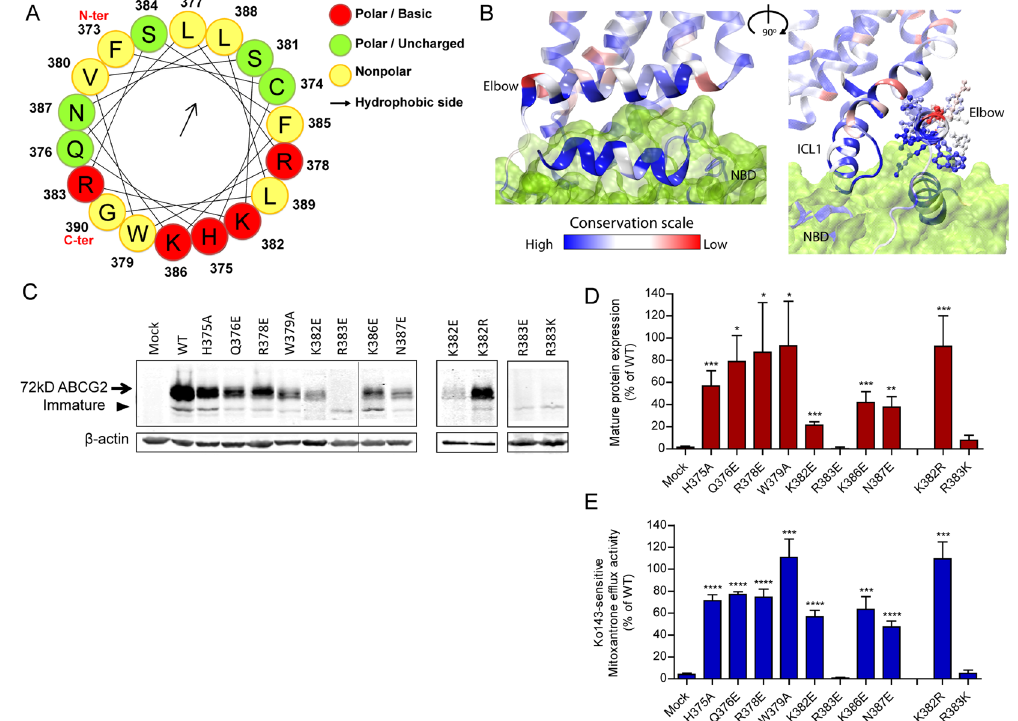
Figure 3. Functional analysis of the elbow helix. Residues in the elbow helix were subjected to mutational changes as indicated followed by their expression in HEK293 cells. ( A ) Elbow helix is depicted in a helical wheel projection using the HeliQuest analysis (http://heliquest.ipmc.cnrs.fr/) to reveal amphipathic properties. Residues are indicated in colored balls, charged/basic (red); polar (green); nonpolar (yellow); the arrow indicates orientation towards the hydrophobic membrane core (arrow). ( B ) Conserved motifs at the transmission interface of ABCG2 shown two views rotated by 90°. The degree of conservation among mammalian ABCGs is indicated as color-gradient; high conservation (blue) to low conservation (red). NBD surface (green). Side chains of elbow helix residues are represented as balls-and-sticks; residues not at atomic scale. ( C ) Immunodetection of ABCG2 variants after transfection into HEK293 cells. β -actin was used as an internal loading control. ( D ) Quantification of immunoblots from several independent experiments (n = 2–7), using the Odyssey system. ABCG2 signals are individually normalized to β -actin and shown as percentage of WT. The blots from different gels were divided by the white spaces. ( E ) Mitoxantrone efflux in HEK293 cells transfected with elbow helix mutants. Mitoxantrone accumulation was quantified in the presence and absence of Ko143 after incubation at 37 °C for 20 min. Ko143-sensitive mitoxantrone efflux is given as percentage activity relative to WT. Data are from several independent experiments (n = 2–7). All results are represented as means with SEM; **** P < 0.0001; *** P < 0.001; ** P < 0.01; * P < 0.1 vs. empty plasmid-transfected HEK293